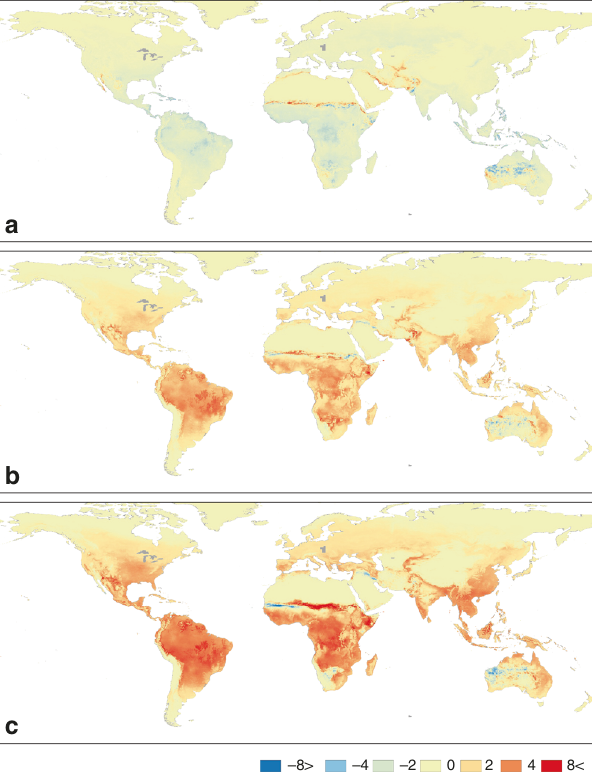
Fig. 2 Changes of LCC of Ae. aegypti between 1950, 2000 and 2050. Differences in LCC relative to LCC in 2000s (2000 – 2004 average). a Comparison with 1950s (1950 – 1954 average); b comparison with 2050s (2050 – 2054 average) under RCP 4.5; and c under RCP 8.5. Decreases in LCC are shown in ‘ cool ’ colours (blue and green) and the increases in ‘ warm ’ colours (orange and red).